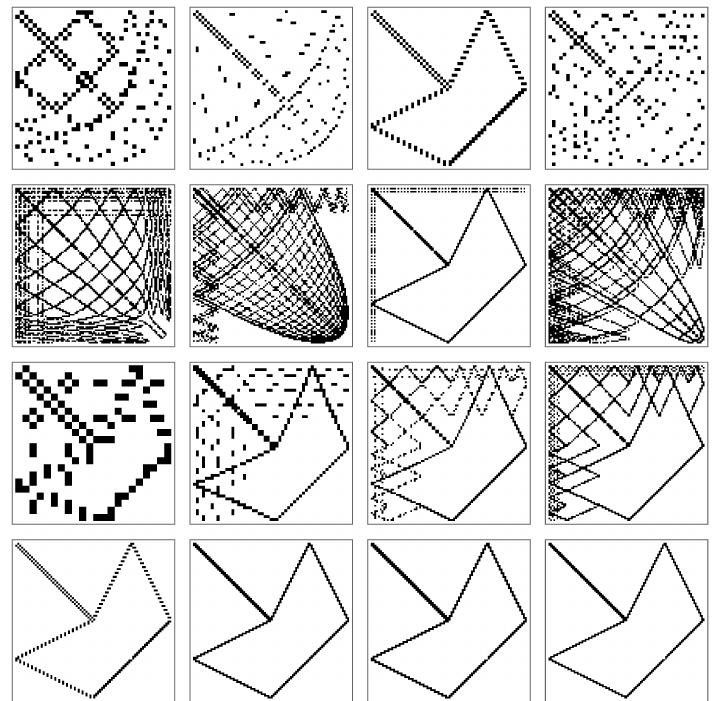
Figure 9. A plot of the entries of the adjacency matrix for several graphs. The special nature of primes and the inherent scaling properties are particularly noticeable. The top shows the typical differences in the adjacency matrices for primes and non-primes by collecting G 51 , G 52 , G 53 , and G 54 . The second row shows G 51 2 , G 52 2 , G 53 2 , and G 54 2 . The third row shows G 5 2 , G 5 3 , G 5 4 , and G 5 5 . The bottom row show several examples of other primes: G 79 , G 179 , G 251 , and G 887